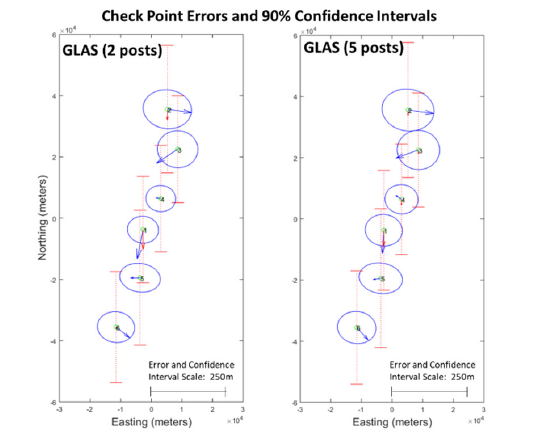
Figures obtained from custom MATLAB code Figure 6. GLAS (2 posts) and GLAS (5 posts) ChkP errors and 90% confidence intervals (Cis)